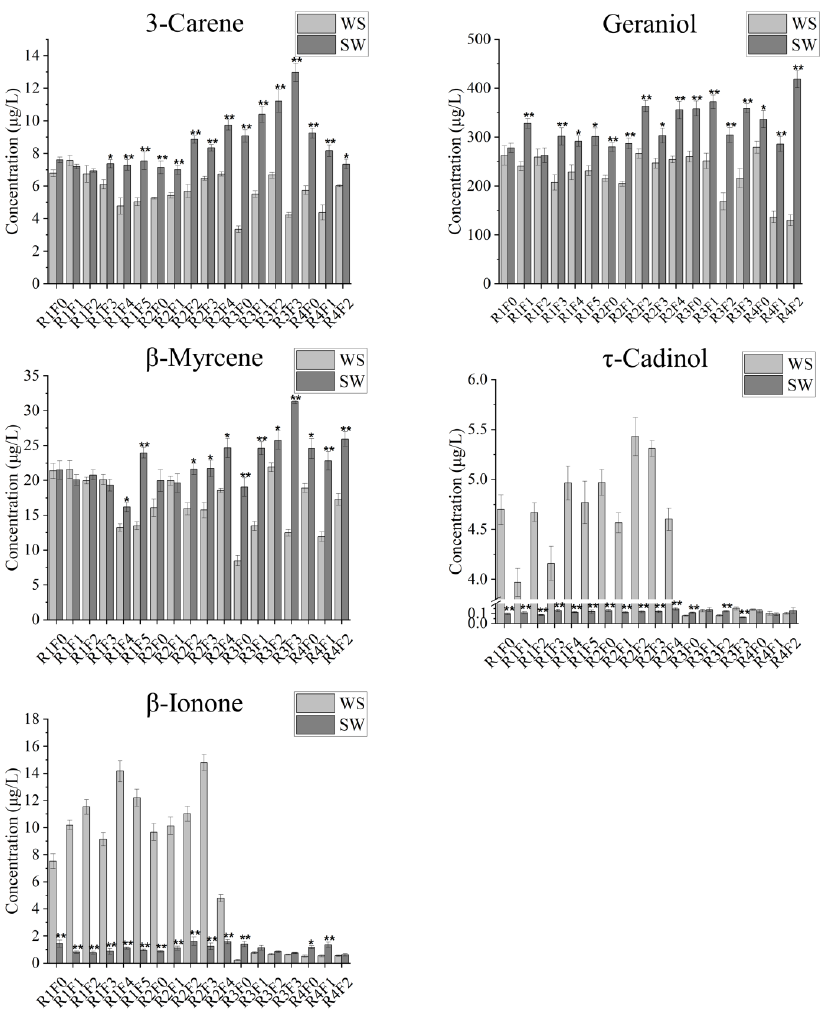
Figure 4. Concentrations of the principal volatile compounds responsible for aromas in black teas processed by withering-shaking and shaking-withering (* p < 0.05, ** p <